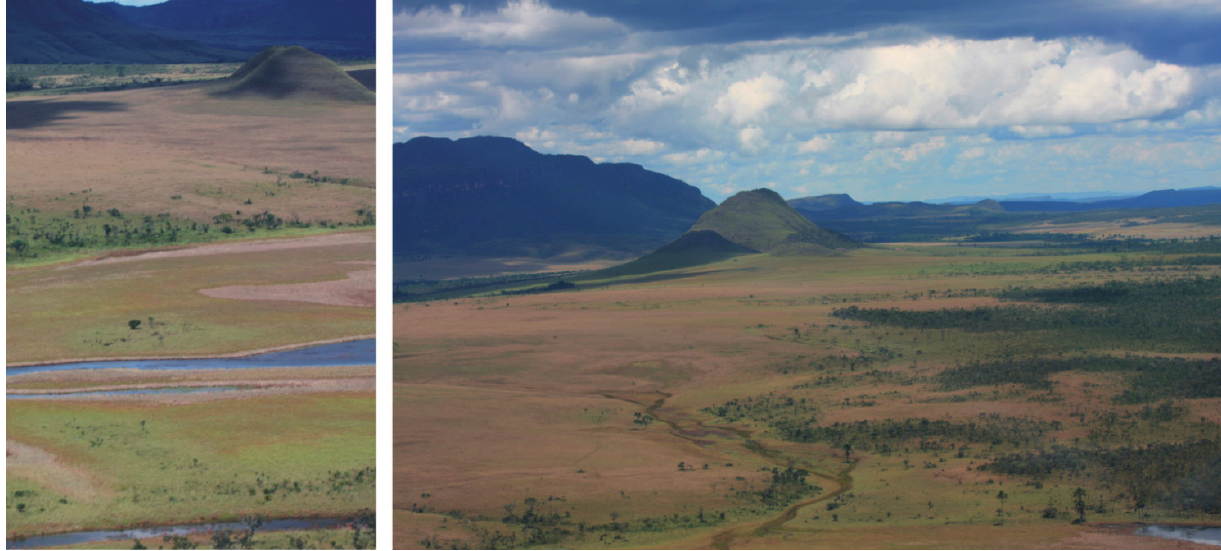
Figure 2. Panoramic photographs of the open grasslands in the Chapada dos Veadeiros National